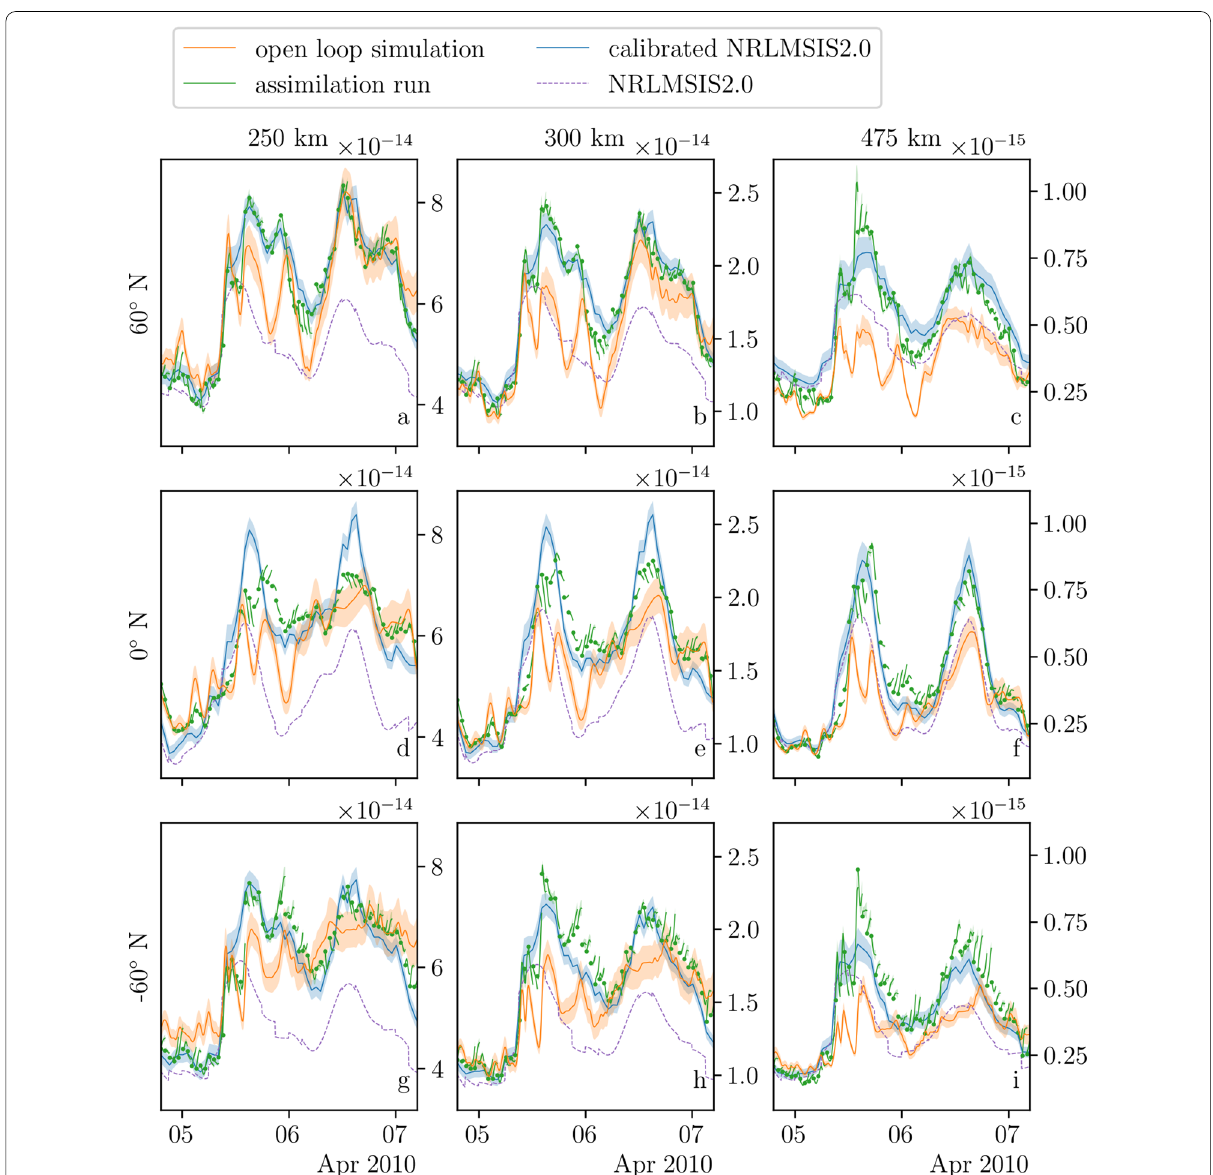
Fig. 7 Each panel contains time series of neutral density (cid:31) g cm 3 (cid:30) for different cells of the data grid . Each row corresponds to a geocentric latitude and each column to an ellipsoidal height. The longitude is always 0 ◦ E . The panels of each column share the same y-axis. The errors bands show the standard deviation. This figure shows 2 days of the experiment including the storm at 5th